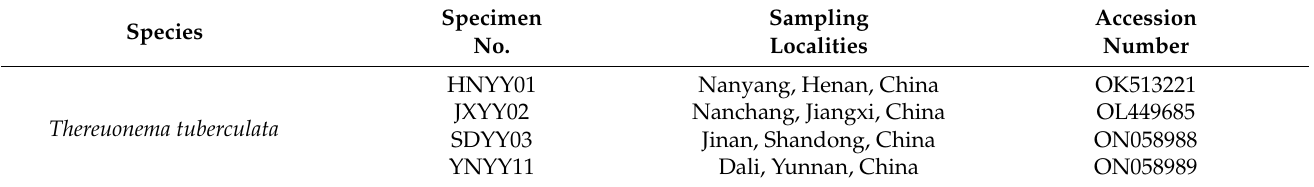
Table 1. Information on specimen sources of the samples used in this study and NCBI GenBank accession